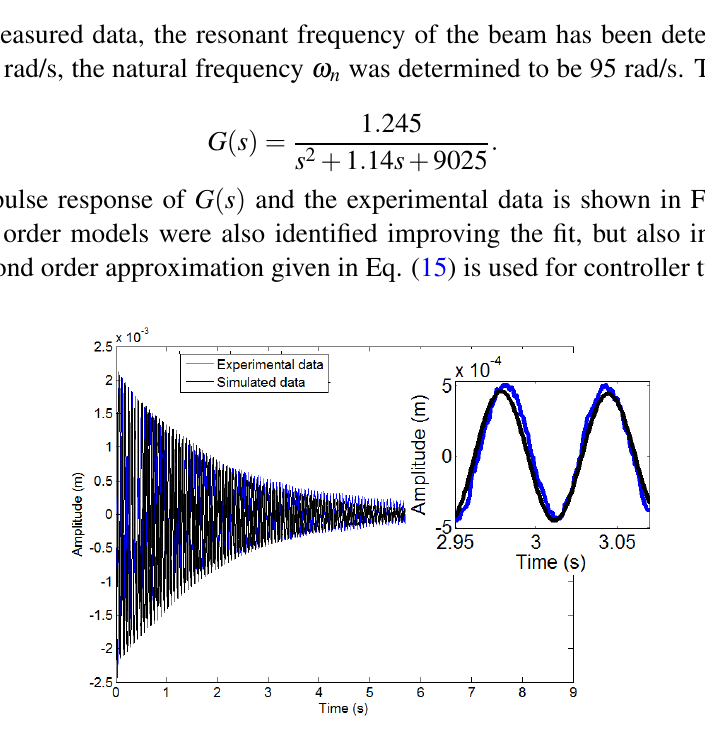
Fig. 3 Experimental and simulation of impulse response of the smart